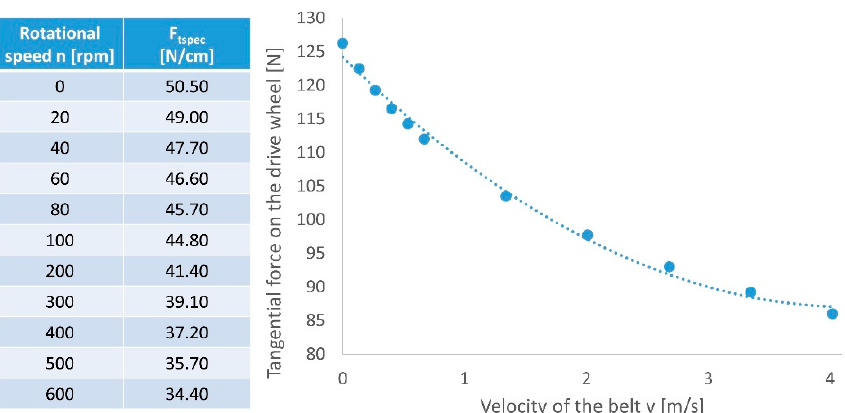
Figure 7. The catalog data for the belt regarding the influence of rotation speed n (rpm) on the allowable distributed load on a single tooth F tspec (N/cm) together with the characteristic of the tangential force as a function of the belt linear velocity for belt wheel diameter D = 128 mm and belt width W = 25 mm [28].